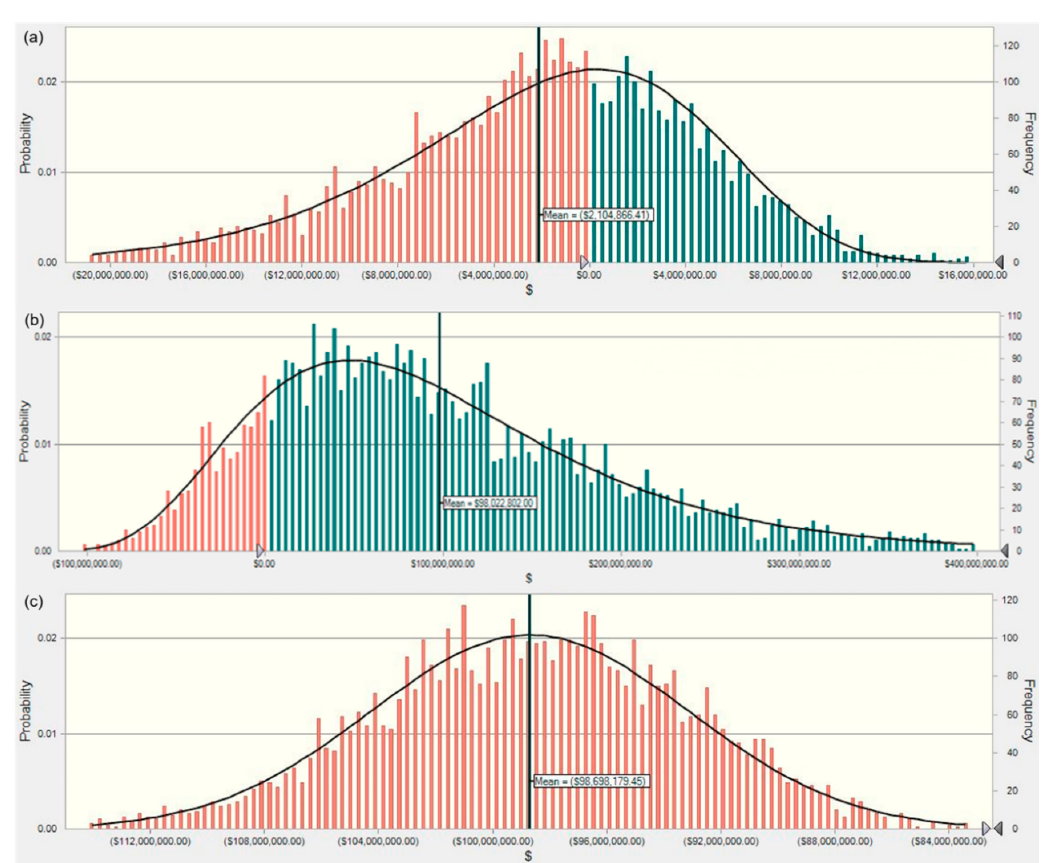
Figure 6. Fitness of statistical distributions of uncertainties: ( a ) pellet, ( b ) biopower, and ( c ) biofuel. For pellet fuel production, the distribution had an average NPV of − $2,104,886 with a 39.58% of probability of being a profitable investment. To determine the best fitted distribution, the Anderson– Darling factor was calculated. A Weibull distribution showed the best fit with lowest Anderson– Darling factor of 4.04. In the biopower production pathway, the probability of being profitable was 85.23% with the uncertainty factors introduced. The forecast NPV ranged from − $15.28 million to $233.29 million for an 80% credible interval. A Lognormal distribution with a mean value of − $2.99 million, and standard deviation value of $9.08 million, was best for determining the probability prediction for biopower production. The probability for a biofuel plant to be profitable was zero. A beta distribution was best for representing the uncertainty distribution.